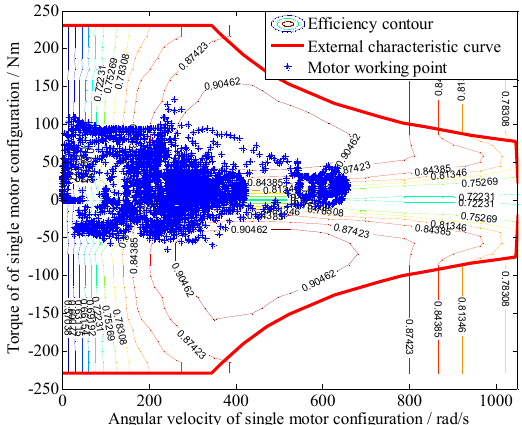
Figure 7. Motor working points of single motor configuration.